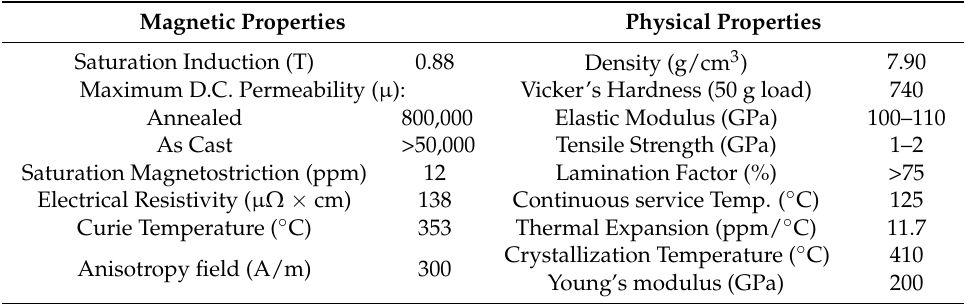
Table 1. The magnetic properties and physical properties of Metglas 2826 MB, the most MES (Magnetoelastic sensors)